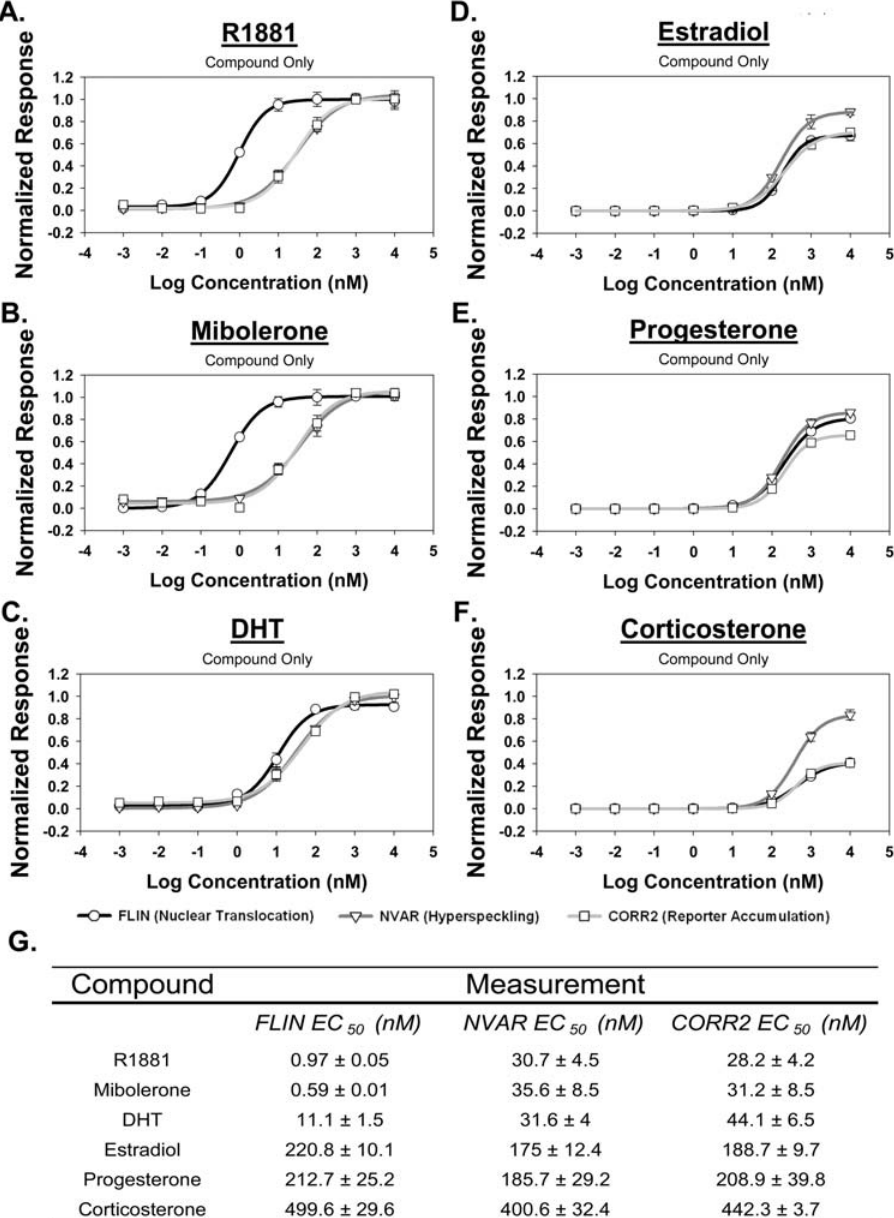
Figure 4. Dose dependent effects measured in panel of steroid compounds. The differential effects of various steroidal compounds on AR nuclear translocation, nuclear hyperspeckling, and transcriptional reporter gene activity in HeLa GFP-AR. Cells transfected with pARR-2PB-dsRED2skl reporter vector and maintained in 5% SD-FBS media for 12 hr. Cells were treated with indicated compound for 18 hr in 5%SD-FBS. Results normalized to negative (no treatment) and positive (R1881) controls. Tested compounds include known AR agonist R1881 ( A ), mibolerone ( B ), and DHT( C ) as well as other steroidal compounds estradiol ( D ), progesterone ( E ) and corticosterone ( F ). EC50 values calculated using SigmaPlot 4-parameter curve fitting tool and presented 6 std. error ( G ). Data represents average of 8